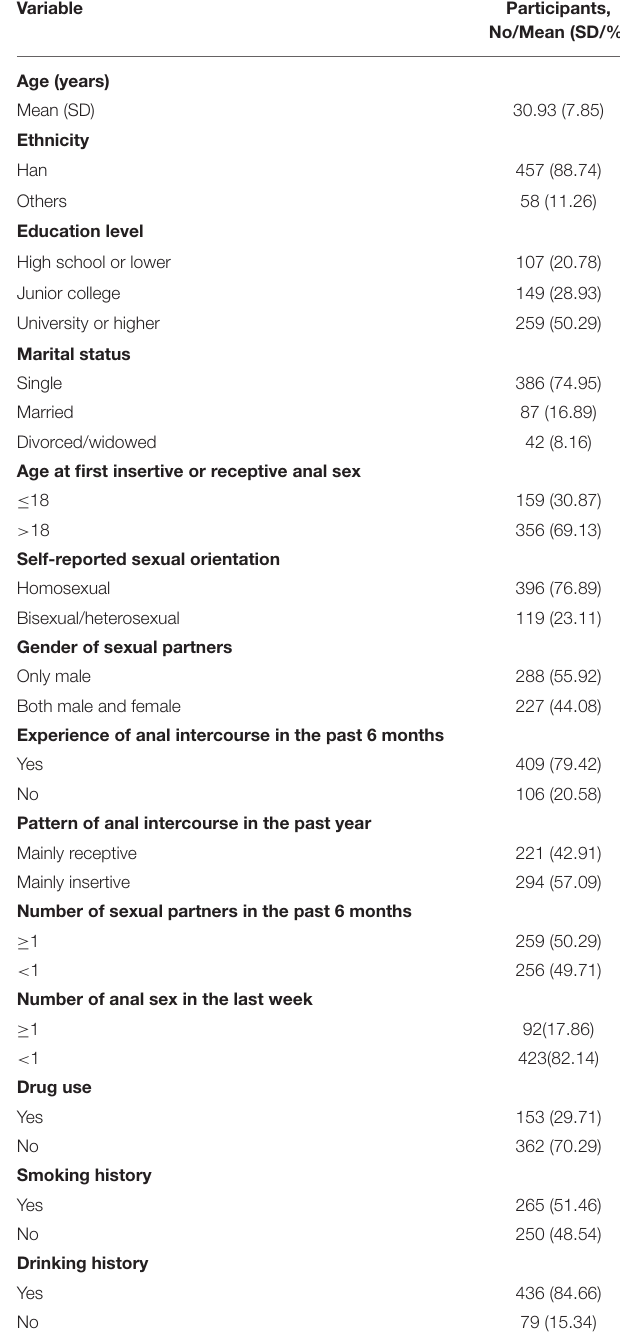
TABLE 1 | Demographic and sexual behaviors among human immunodeficiency virus (HIV)-negative men who have sex with men (MSM) at baseline ( N = 515).